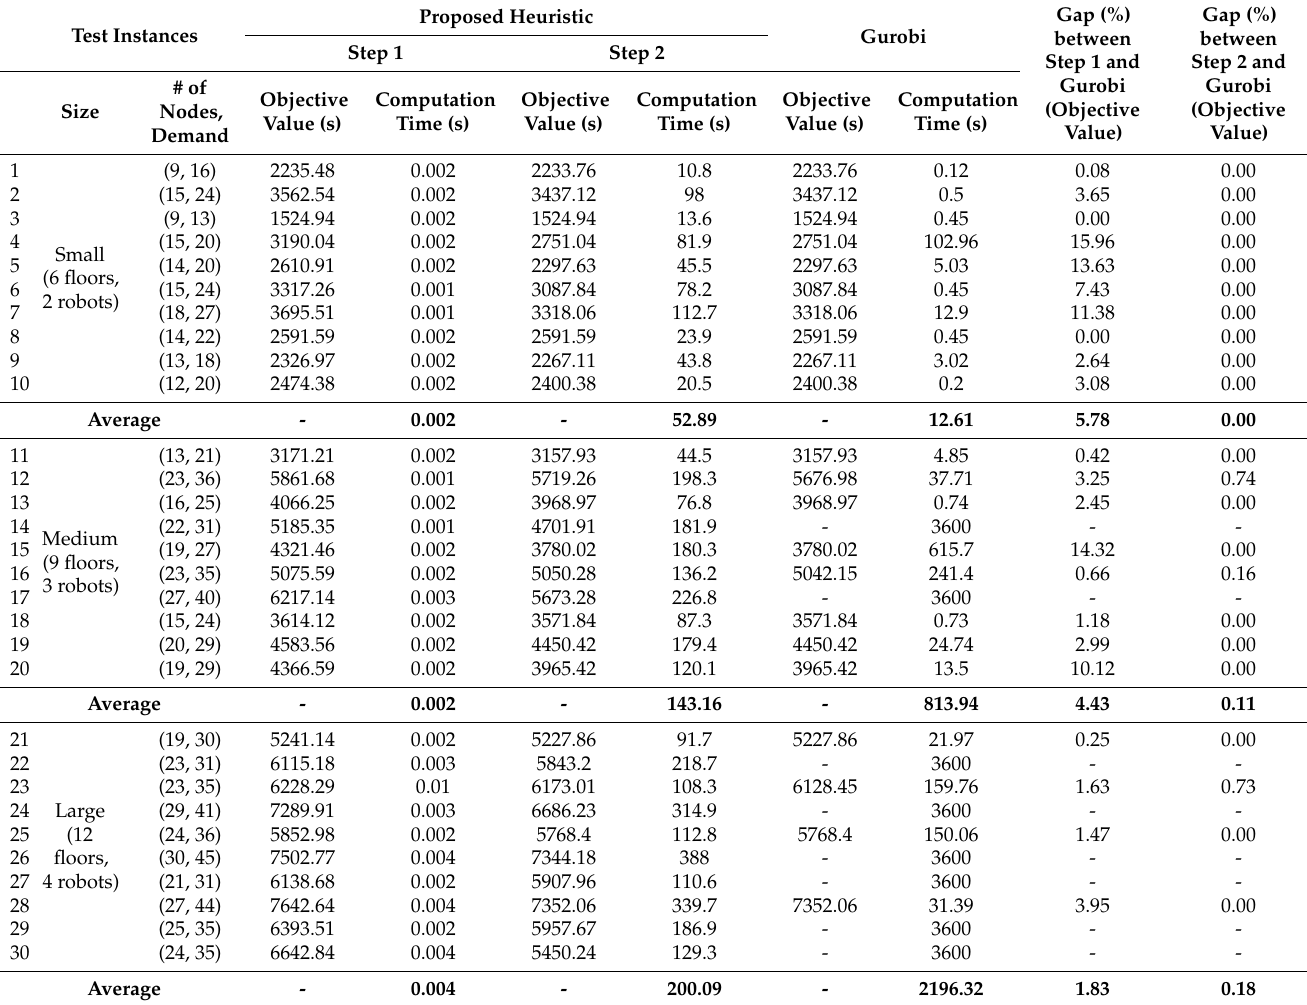
Table 7. Comparing the heuristic with the commercial optimizer on various-sized